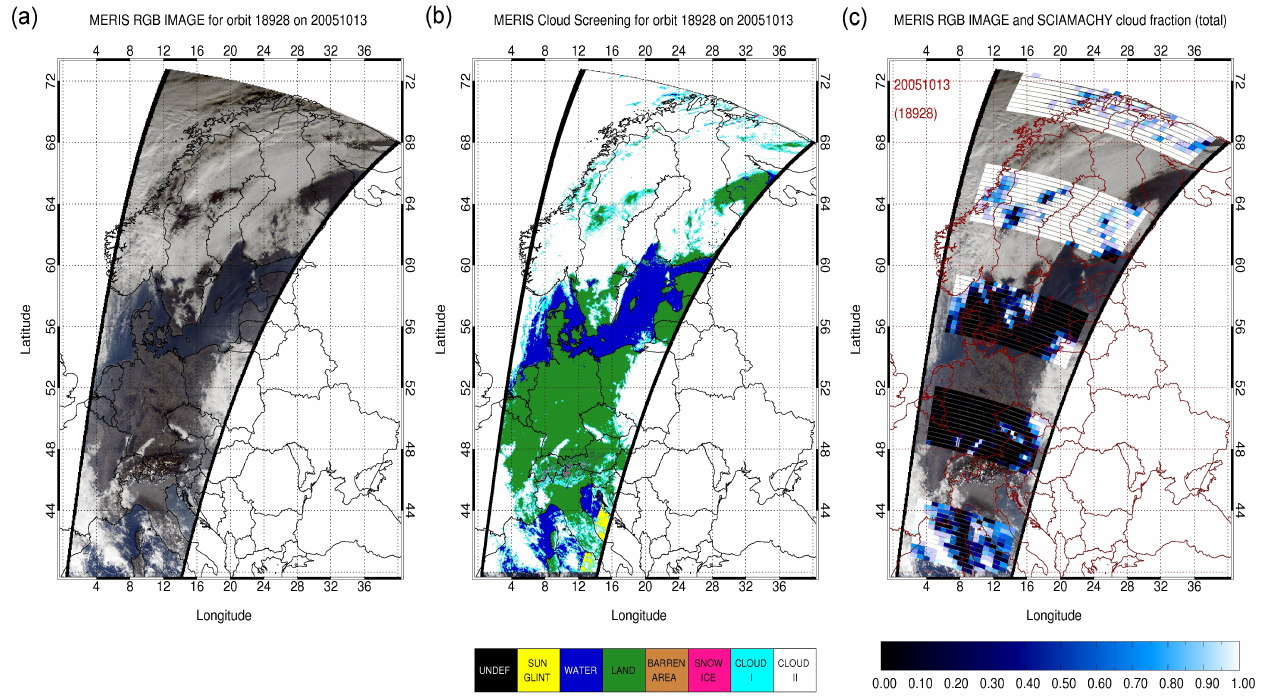
Fig. 4. Maps showing a section of orbit 18928 on the 13th of October 2005 covering northern and central Europe: (a) MERIS RGB image, (b) MICROS-MERIS cloud screening and (c) MICROS-SCIAMACHY cloud fraction (at